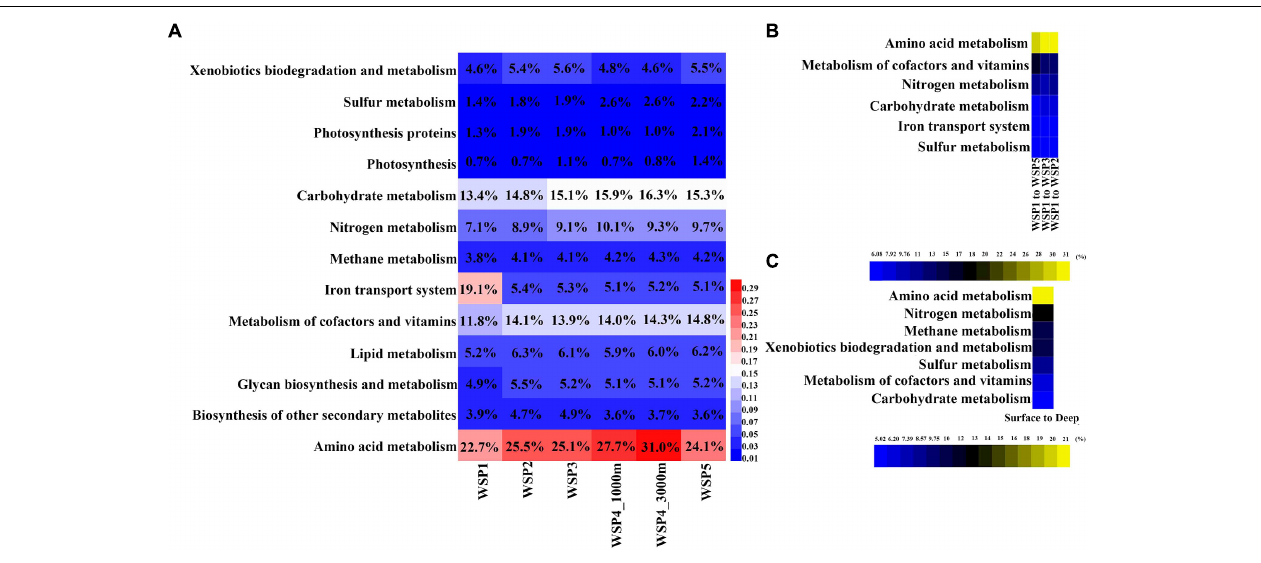
FIGURE 5 | The relative abundance of functional genes in KEGG metabolism modules (A) , and their contribution to the difference between surface and deep waters (B) , and between the surface samples (C) . In each sample, the abundance of each KEGG module was calculated by summing the coverage of the genes in it, and then normalized by the sum of all functional genes’